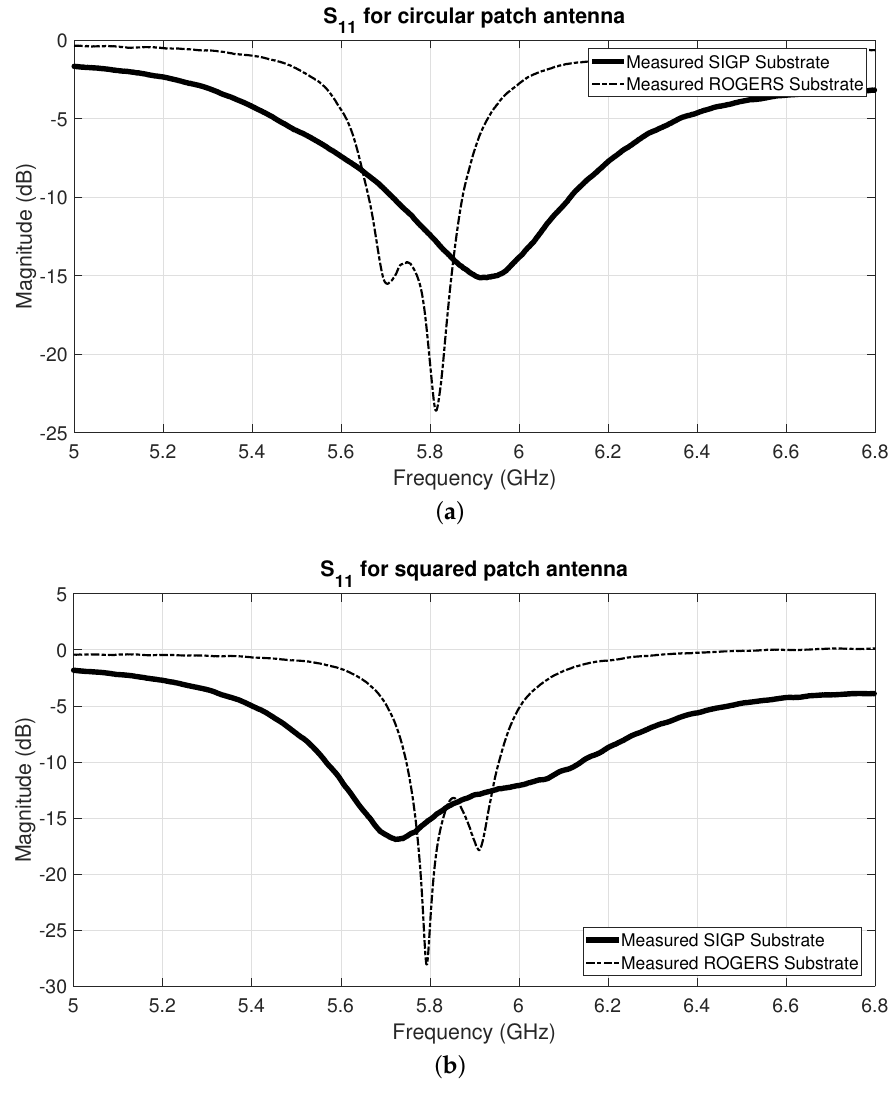
Figure 14. Comparison of the measured S 11 of textile and rigid antennas. ( a ) Circular patch antennas and ( b ) squared patch